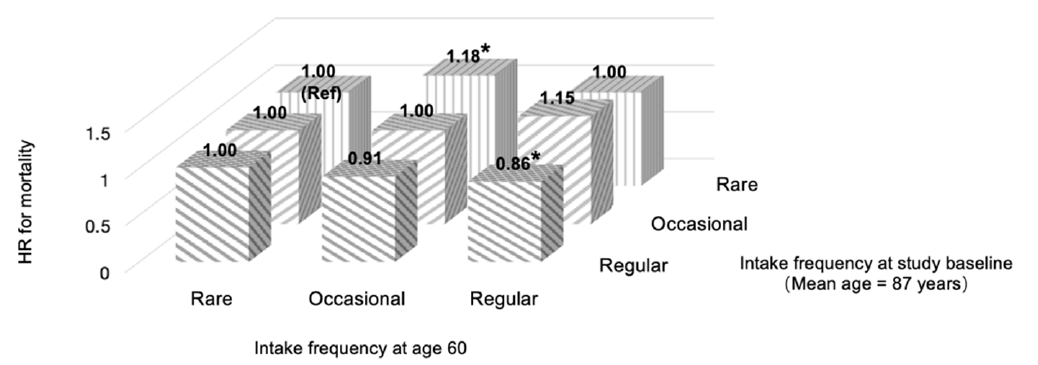
Figure 2. The associations with all-cause mortality of intake frequencies of mushrooms and algae at age 60 and study baseline. Multivariable models were adjusted for age, gender, ethnicity, level of education, type of residence, marital status, income level, smoking status, alcohol consumption, regular exercise, BMI, and major food group consumption (including fresh fruits, fresh vegetables, meat and poultry, fish and aquatic products, preserved vegetables, nuts, legumes, and sugar and sweets). Abbreviation: HR, Hazard Ratio; Ref, reference. * p value < 0.05.